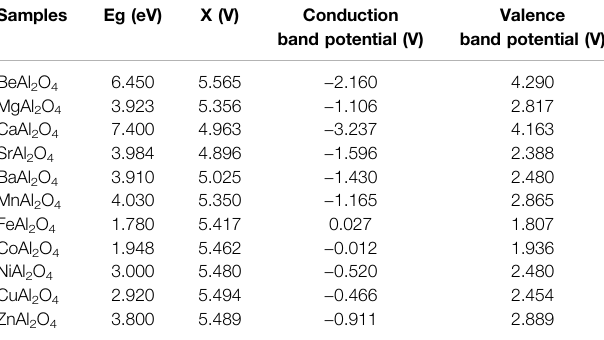
TABLE 1 | The conduction band potential and valence band potential of MAl 2 O 4 photocatalyst.